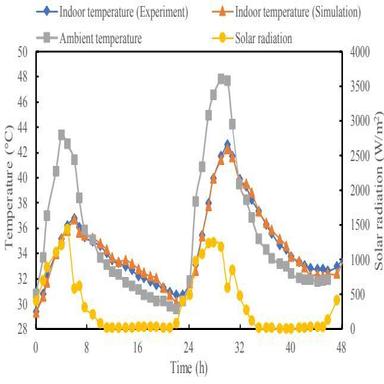
Comparison between experiments and simulations .